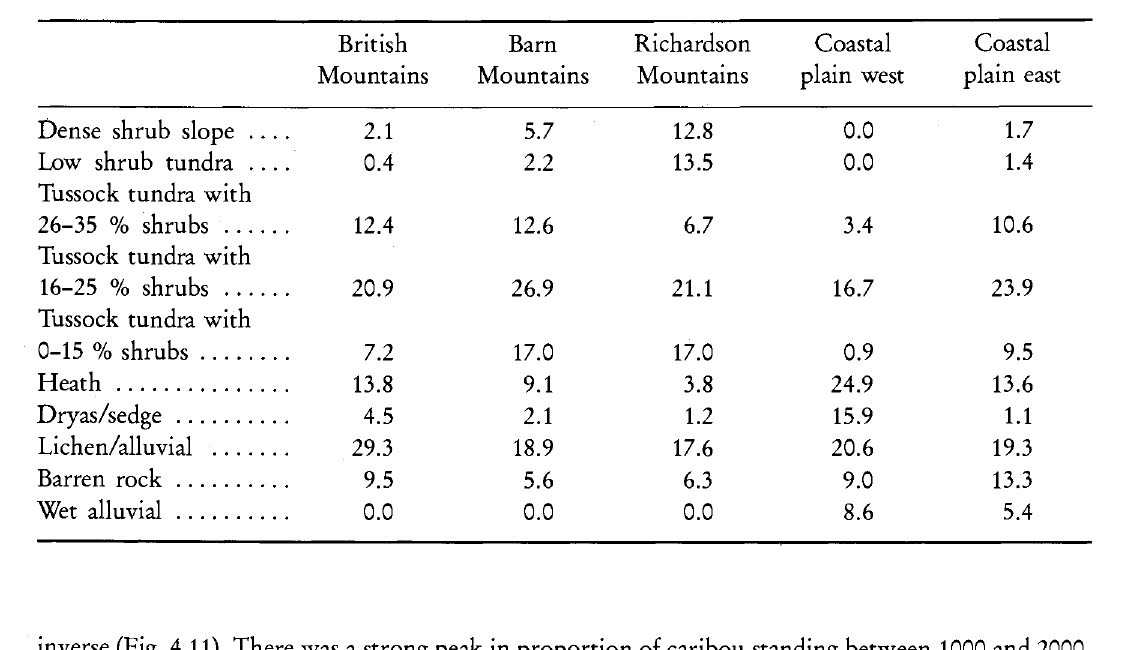
Table 4.7. Percent cover of land cover types found in each sub-region of mapped area. British Barn Richardson Coastal Coastal Mountains Mountains Mountains plain west plain east Dense shrub slope . .. 2.1 5.7 12.8 0.0 1.7 Low shrub tundra . .. 0.4 2.2